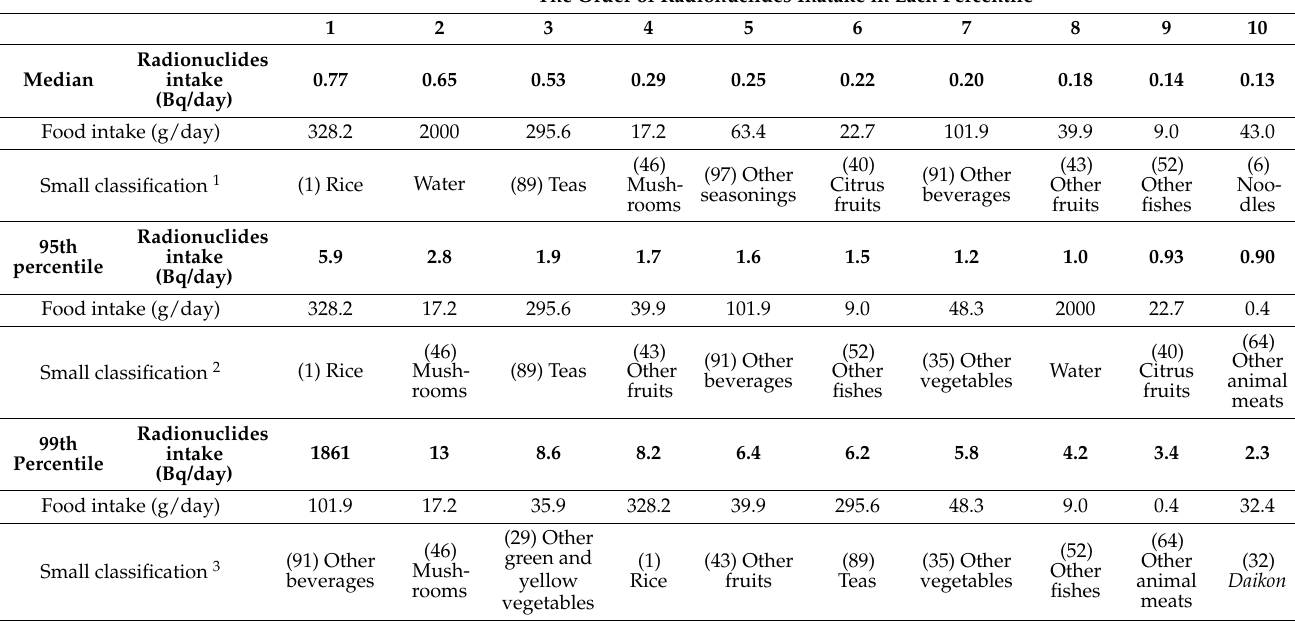
Table 5. Breakdown of high radionuclide intake in FY2012 (without regulation). The top 10 of the 99 food classification in terms of the radionuclide intake per day as calculated by multiplying the sampled monitoring results and food intake are listed. The median, 95th percentile and 99th percentile of the radionuclide intake in virtual 10,000 persons with food intake is represented.